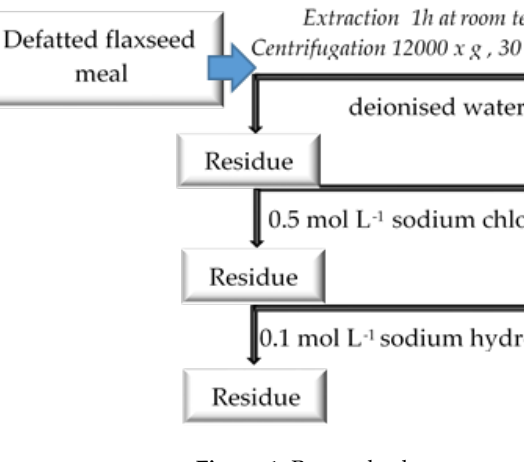
Figure 1. Protocol subsequent extractions of protein fractions from defatted flaxseed meal. Briefly, defatted meal (20 g) was mixed with deionised water (1:10 and 1:15 w / v for Szafir/Oliwin and Jantarol cultivar, respectively) and stirred continuously for 1 h at room temperature. The higher meal-to-water ratio for Jantarol seed extraction was due to the higher content of water-soluble mucilage in these seeds, which increased the viscosity of the solution compared to the other cultivars.